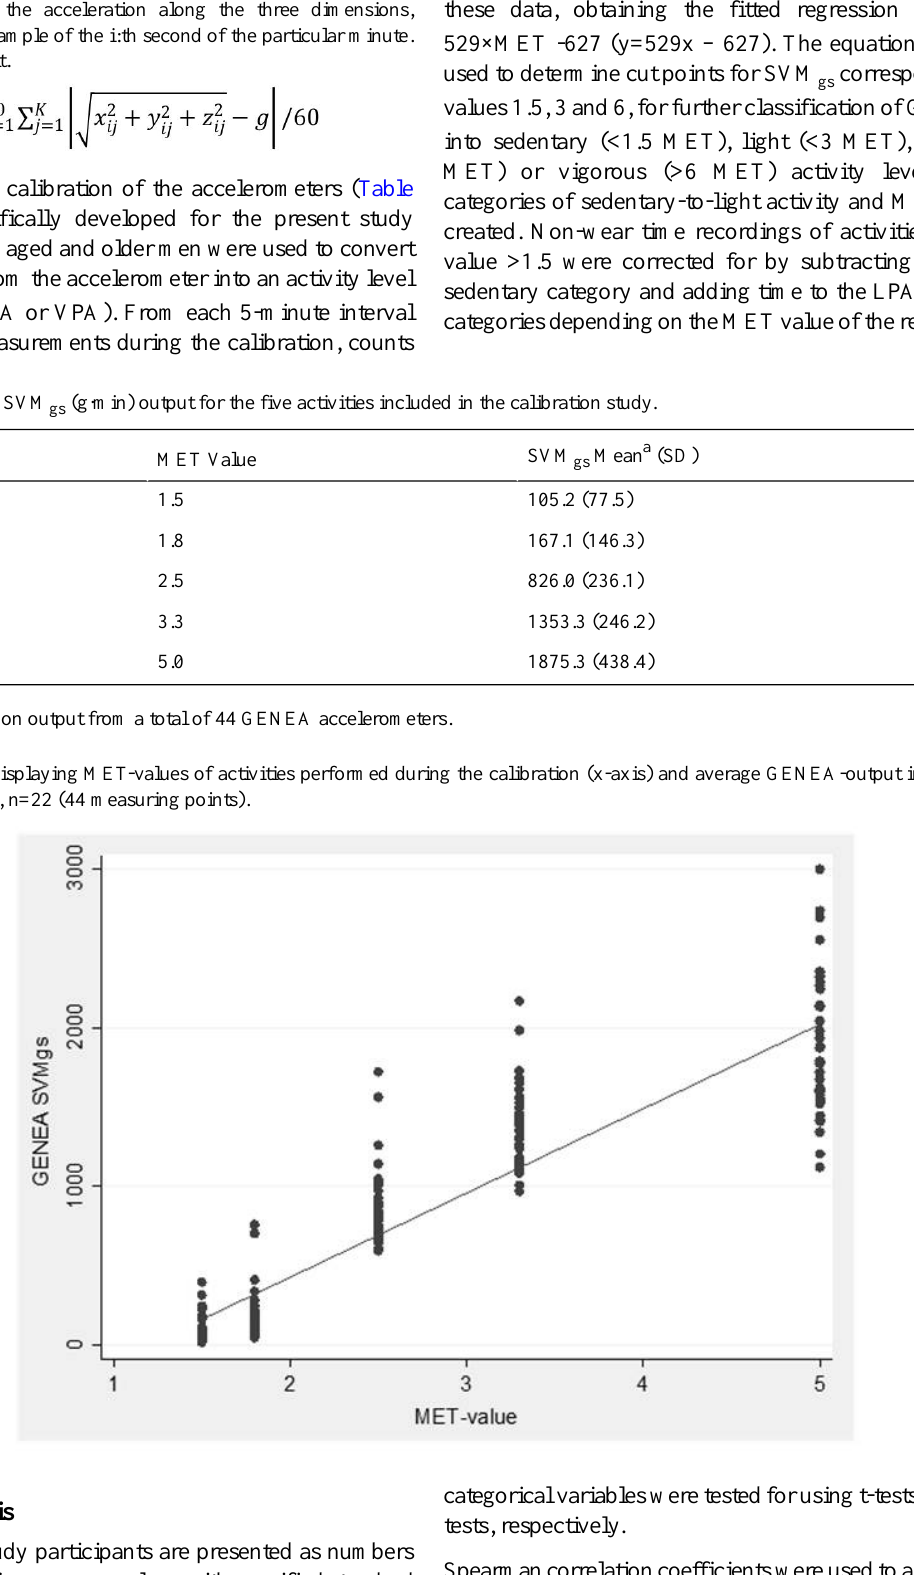
Figure 2. Equation of GENEA output per minute using the post processing software. K is the number of samples per second (K=40 in our study), and x_ij, y_ij, and z_ij is the acceleration along the three dimensions, respectively, at the j:th sample of the i:th second of the particular minute. g is set to 1.00 by default.